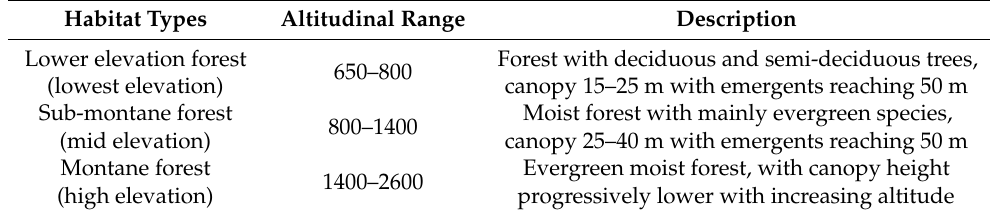
Table 1. Description of the three studied forest habitat types in the Udzungwa Mountains, Tanzania. Habitat